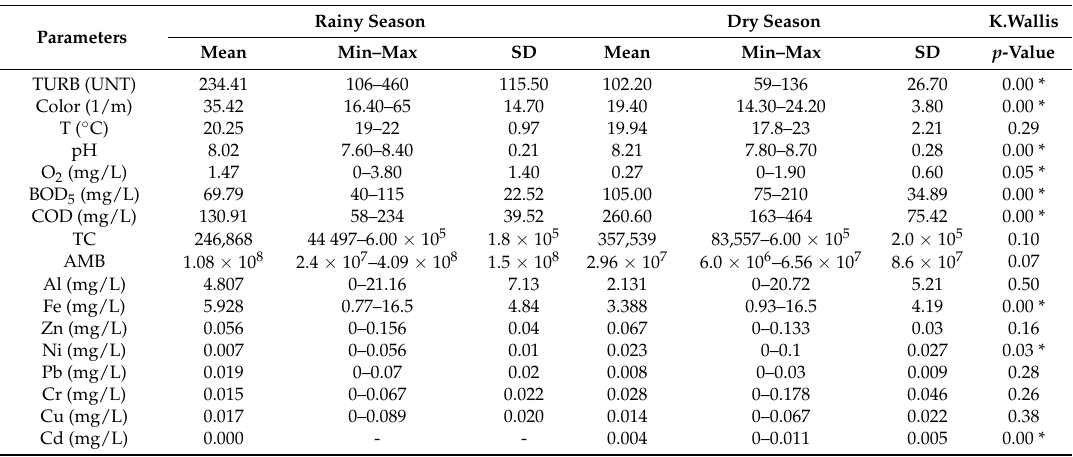
Table 1. The pollution indicators measured in the Atoyac River, showed market variations between drought and